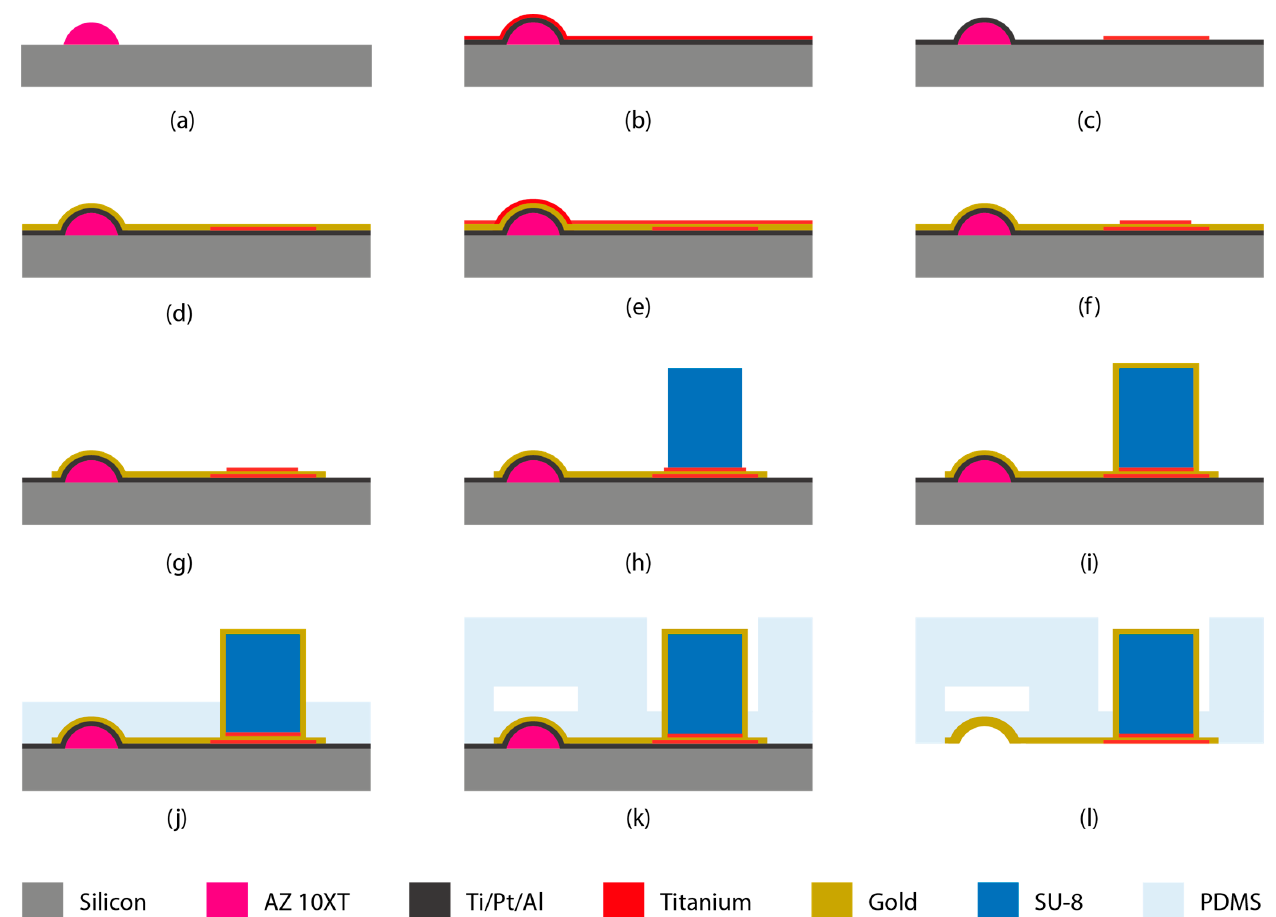
Figure 2. ( a – l ) Wafer level process steps for fabrication of the microfluidic module featuring pseudo-RE and